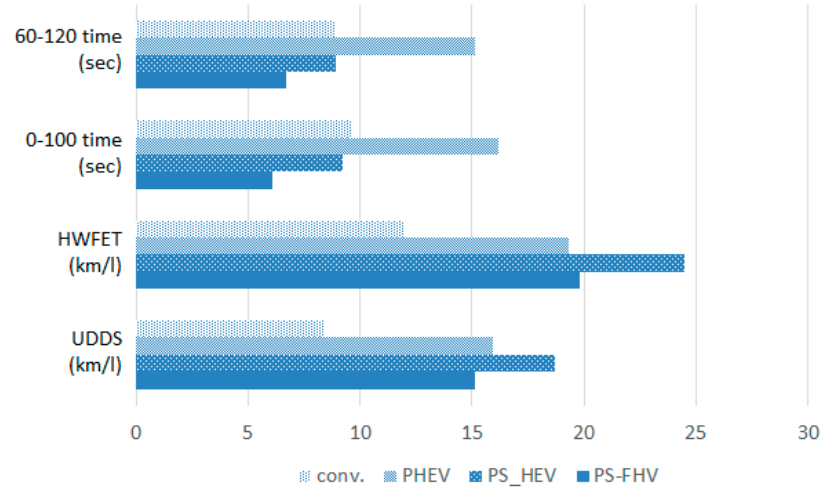
Figure 25. PS-FHV performance estimation versus other vehicle types.